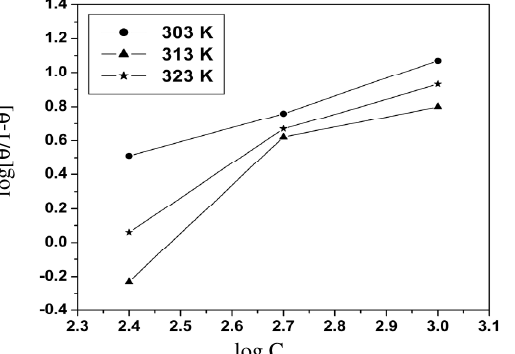
Figure 5. Langmuir adsorption isotherm at different temperatures in 1 N H